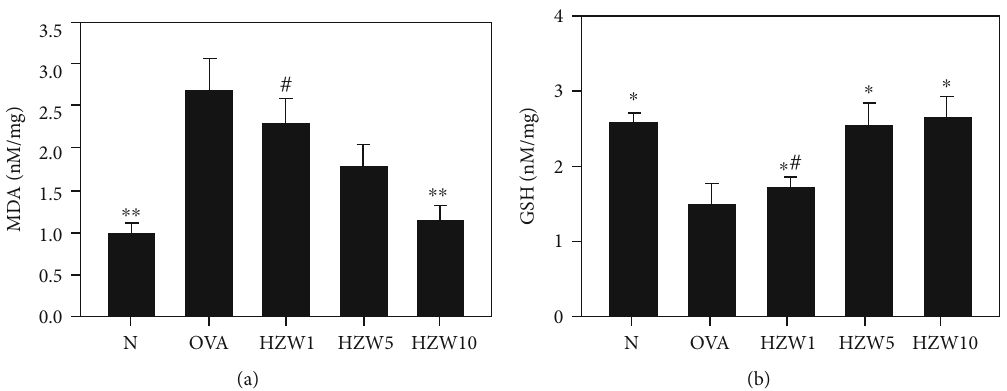
Figure 5: The e ff ects of HZW on oxidative stress factors. The MDA level (a) and GSH activity (b) were measured in the lung tissues of mice. Data are presented as the mean ± SEM . ∗ P < 0 : 05 and ∗∗ P < 0 : 01 compared with the OVA control group. # P < 0 : 05 compared to the HZW10 group.